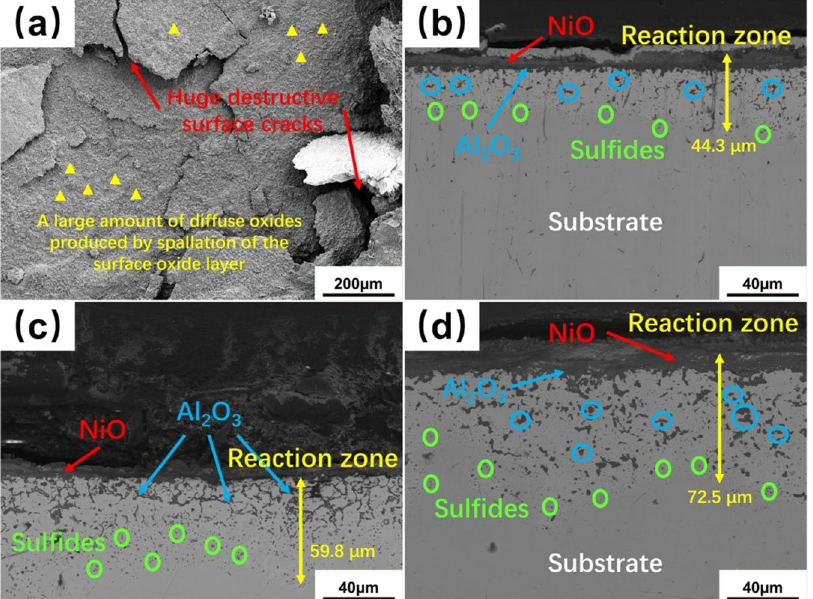
Fig. 2 The surface and cross-section morphologies of the sample after normal hot corrosion at 900 °C. a The surface morphology of the sample after 200 h normal hot corrosion at 900 °C; b the cross-section morphology of the sample after 50 h; c 100 h; and d 200 h normal hot